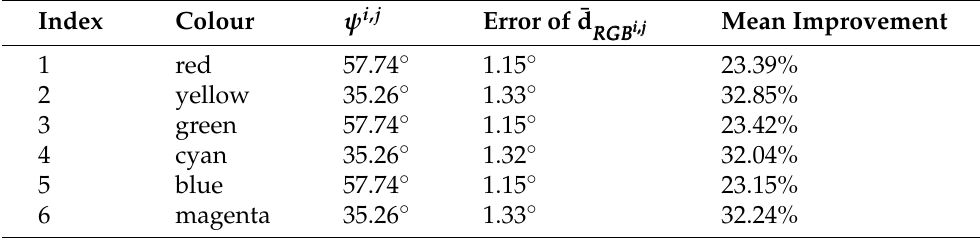
Table 1. Improvement on different-coloured